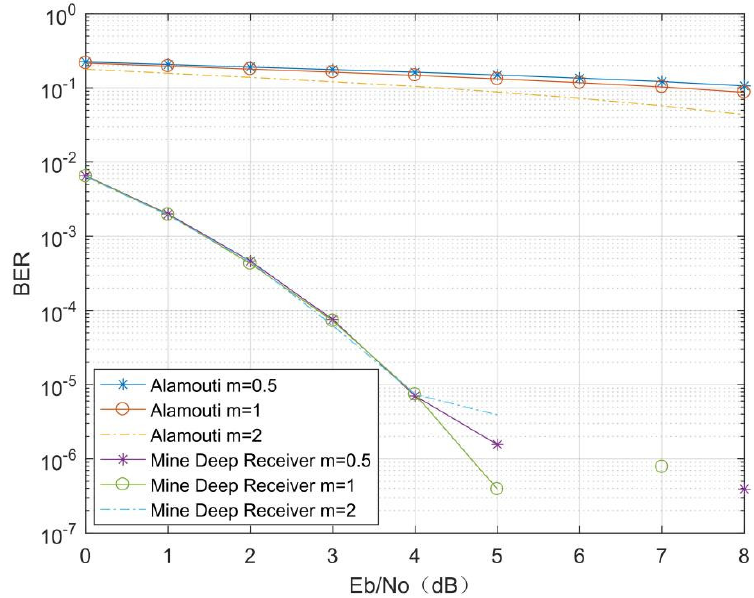
Table 2. Sample of different modulation coding methods. Figure 6. Comparison of the decoding performance in different channel environments.